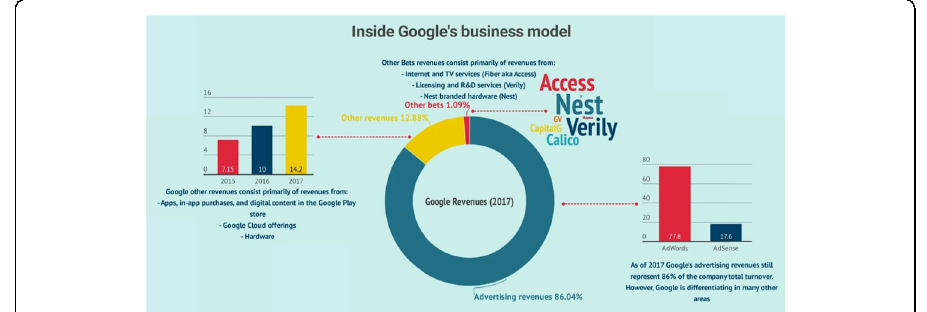
Fig. 7 Inside Google ’ s business